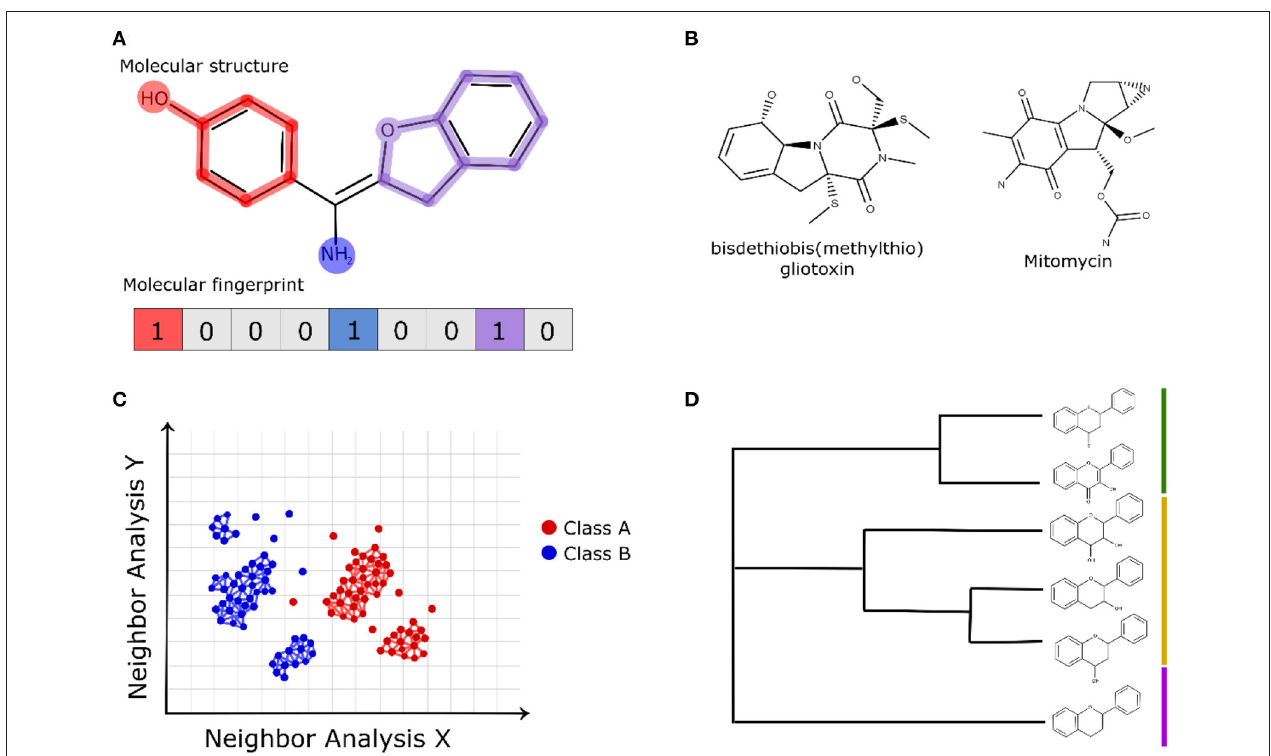
FIGURE 2 | (A) Schematic representation of bits applied in the molecular fingerprints of chemical structures. (B) Fingerprint-based similarity of the natural compound bisdethiobis (methylthio)gliotoxin and the FDA-approved anticancer drug mitomycin ( Galúcio et al., 2019). (C) Schematic view of the chemical space network and (D) hierarchical clustering that apply fingerprint-based descriptors to analyze natural compounds.